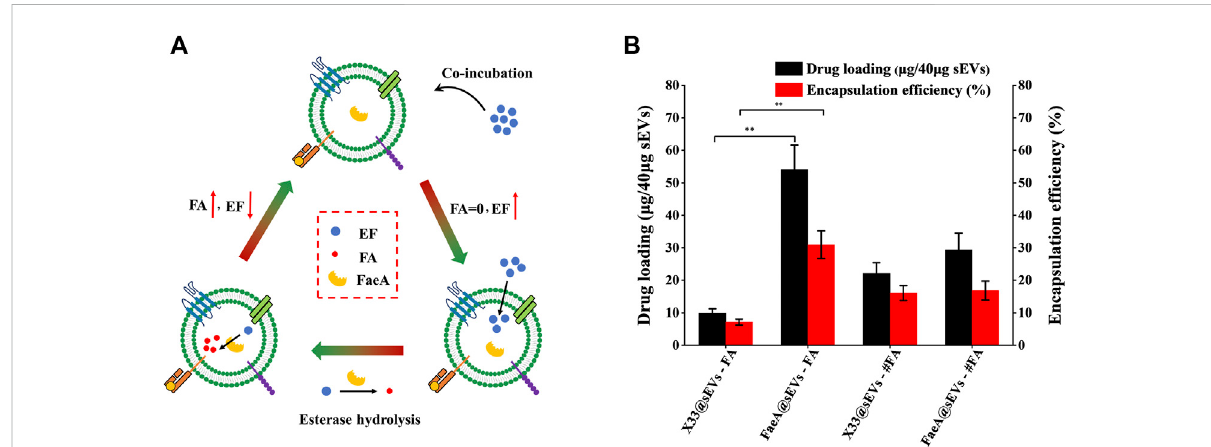
FIGURE 5 Loading ef fi ciency of FaeA@sEVs loaded with active molecules. (A) Schematic representation of the EAL platform. When the EF with high concentrationfromtheoutsideofthemembranetotheinsideofthemembrane,itwillundergoesterasehydrolysistoproduceFAundertheactionof FaeA. This step is equivalent to closing the “ switch ” for the balance of EF concentration between the two sides of the membrane. As long as EF is presentoutsidethemembrane,itwillenterthemembranedependingontheconcentrationdifferencebetweenthetwosidesofthemembrane andreleaseFA.Atthesametime,theiontrappingeffectofbio fi lmcanblocktheoutwardleakageofFA,thusindirectlyachieving theef fi cientloading ofFA insEVs. (B) Loadingef fi ciency of engineered sEVs loaded withactive molecules. Note: X33@sEVs-#FA and FaeA@sEVs-#FArepresent thedrug loading ef fi ciency obtained by replacing the loaded drug EF with FA, respectively. ( n = 3, mean ± SD, **p < 0.01)